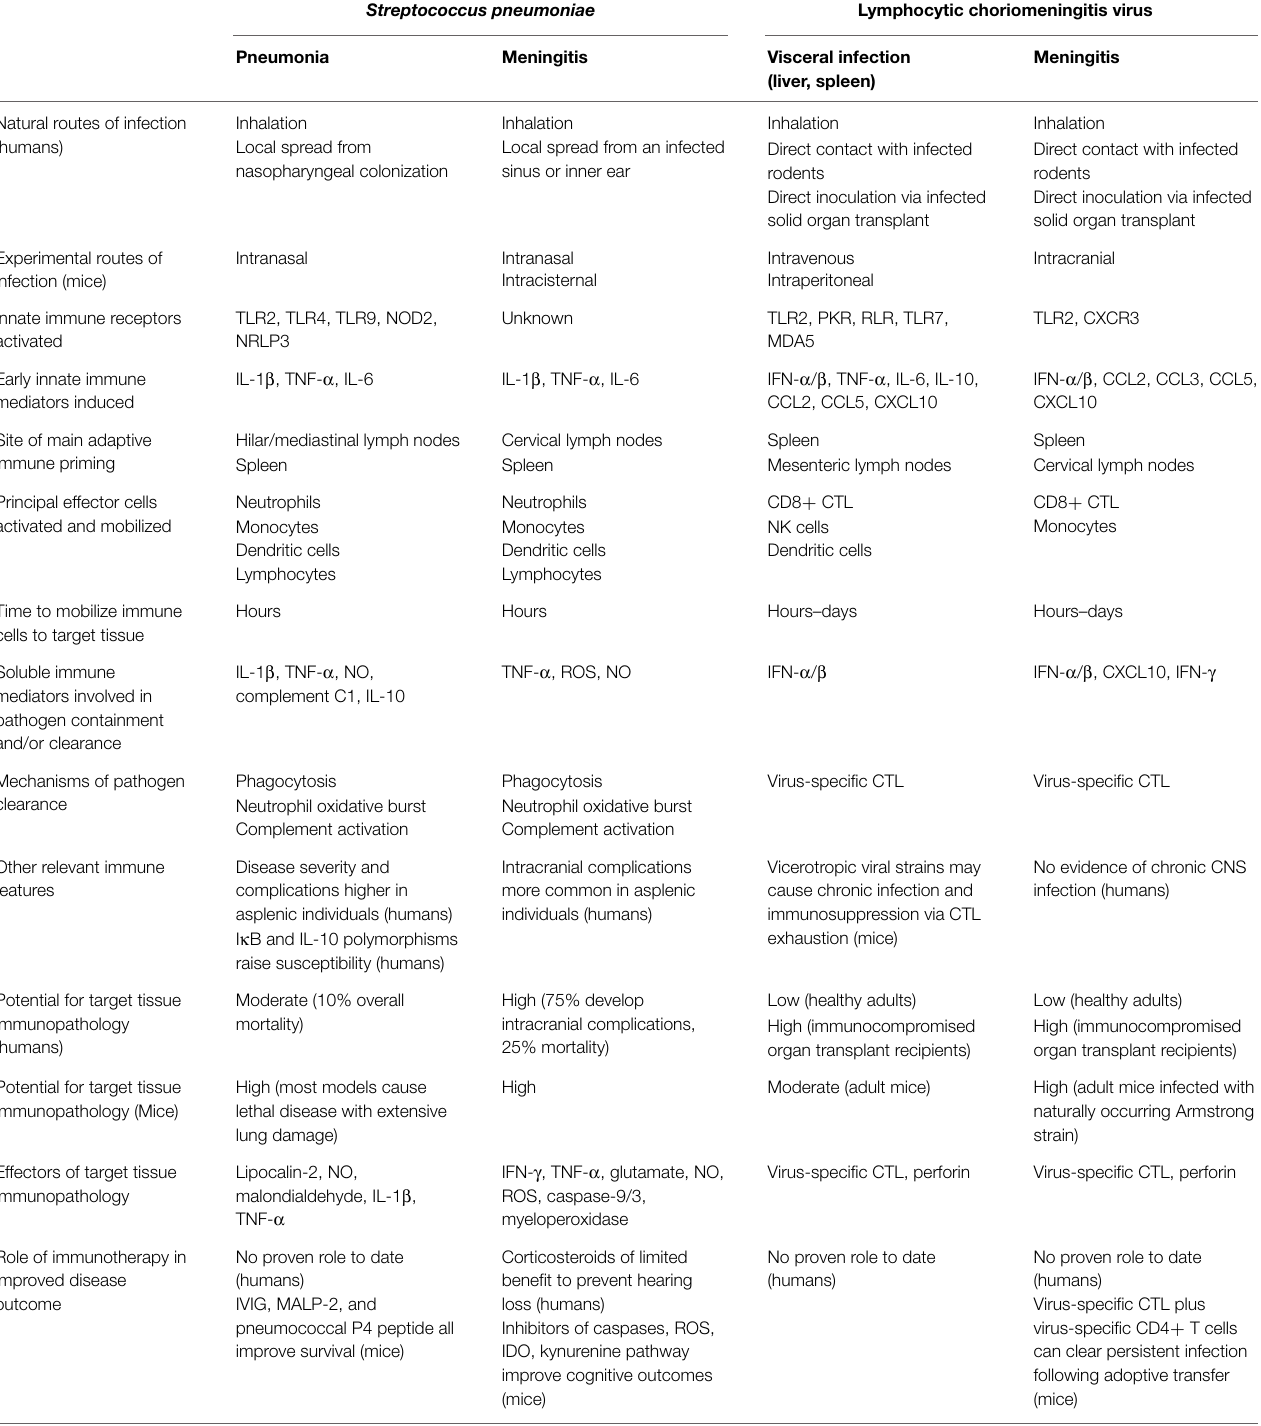
TABLE 1 | Pathogenesis and host responses elicited during a prototype bacterial ( Streptococcus pneumoniae ) or viral (lymphocytic choriomeningitis virus) infection of adult hosts when localized in either the periphery or the CNS [data adapted from Ref. (10–15)] a